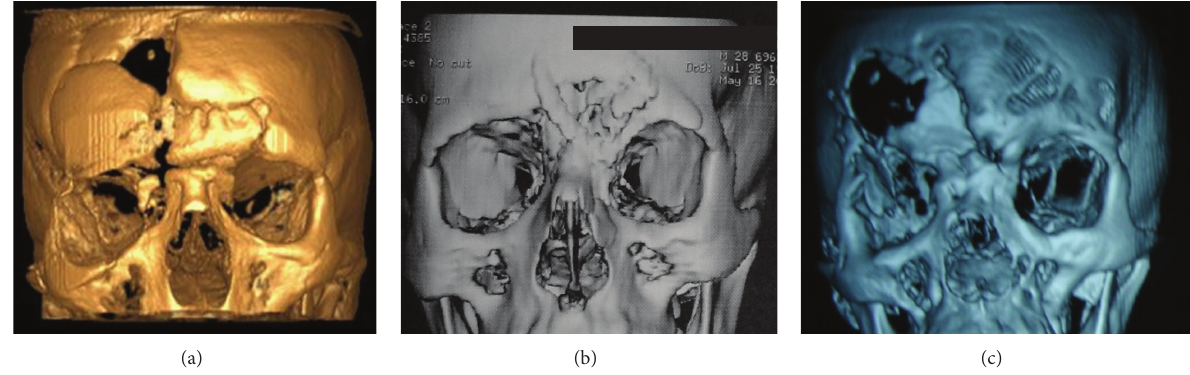
Figure 2: Preoperative 3D CT scans for Cases 1, 2, and 3 ((a), (b), and (c),